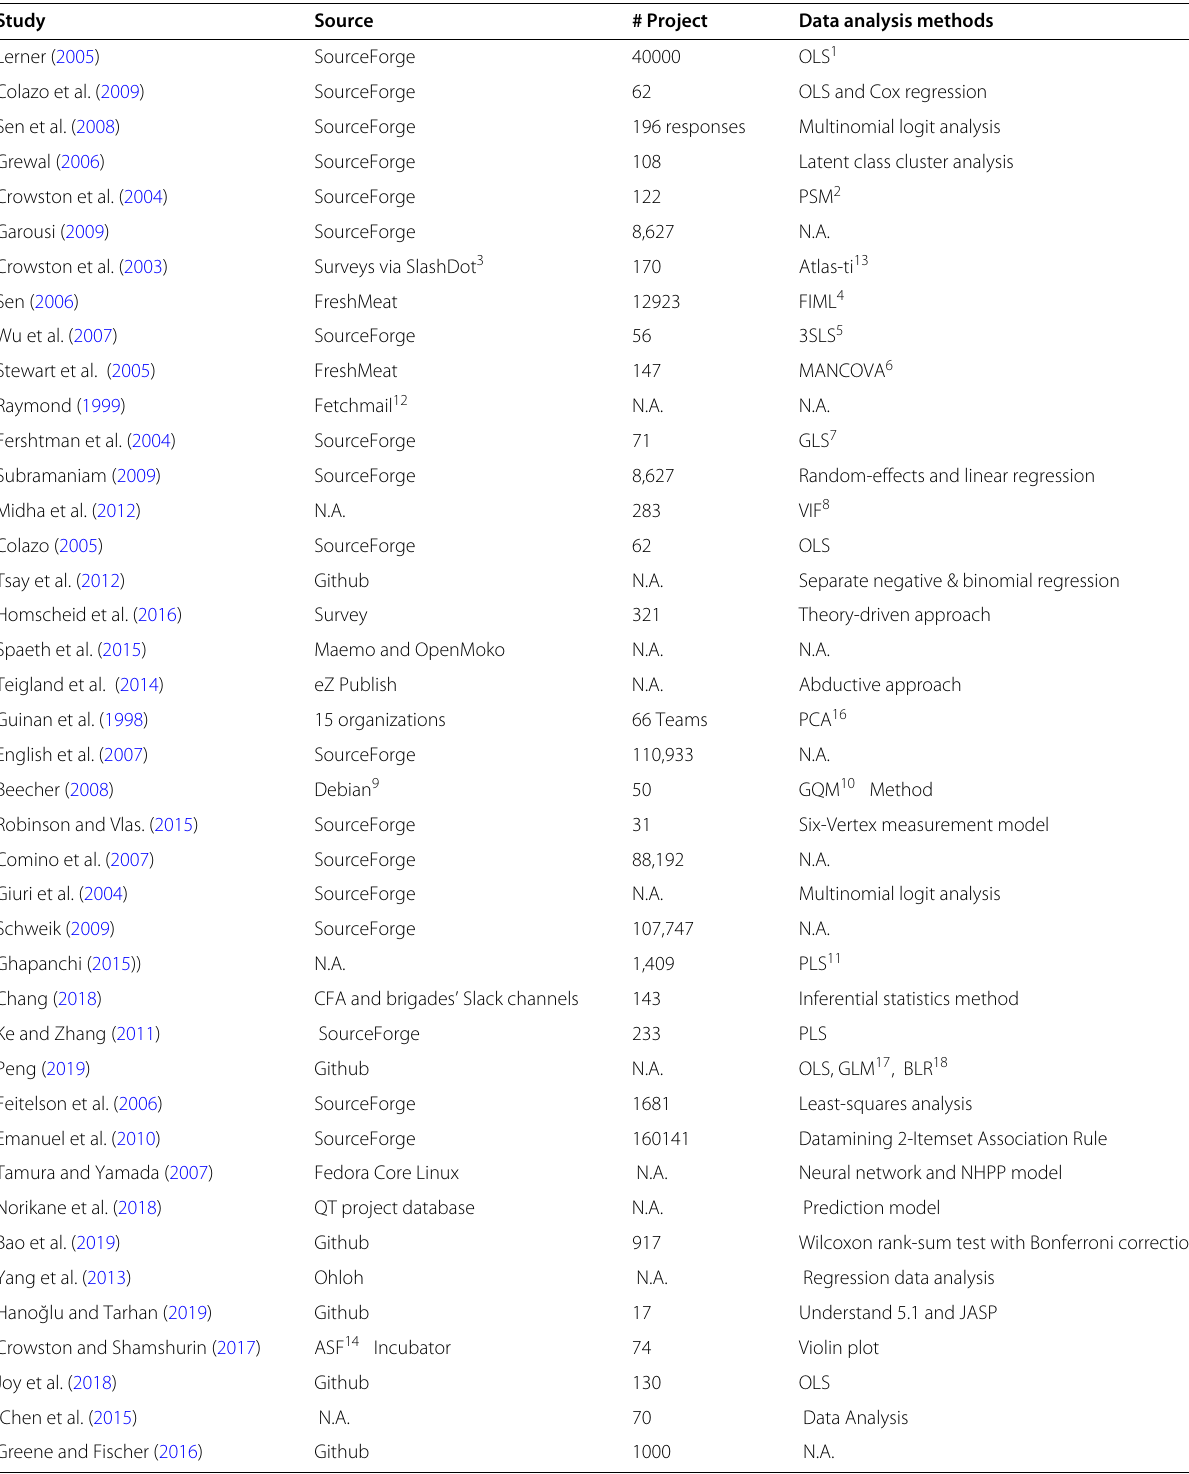
Table 1 Statistics of investigated papers. “Source” denotes where the projects are collected for investigation, “# Project” indicates the number of investigated projects, and “Approach” shows what methods are used to obtain the